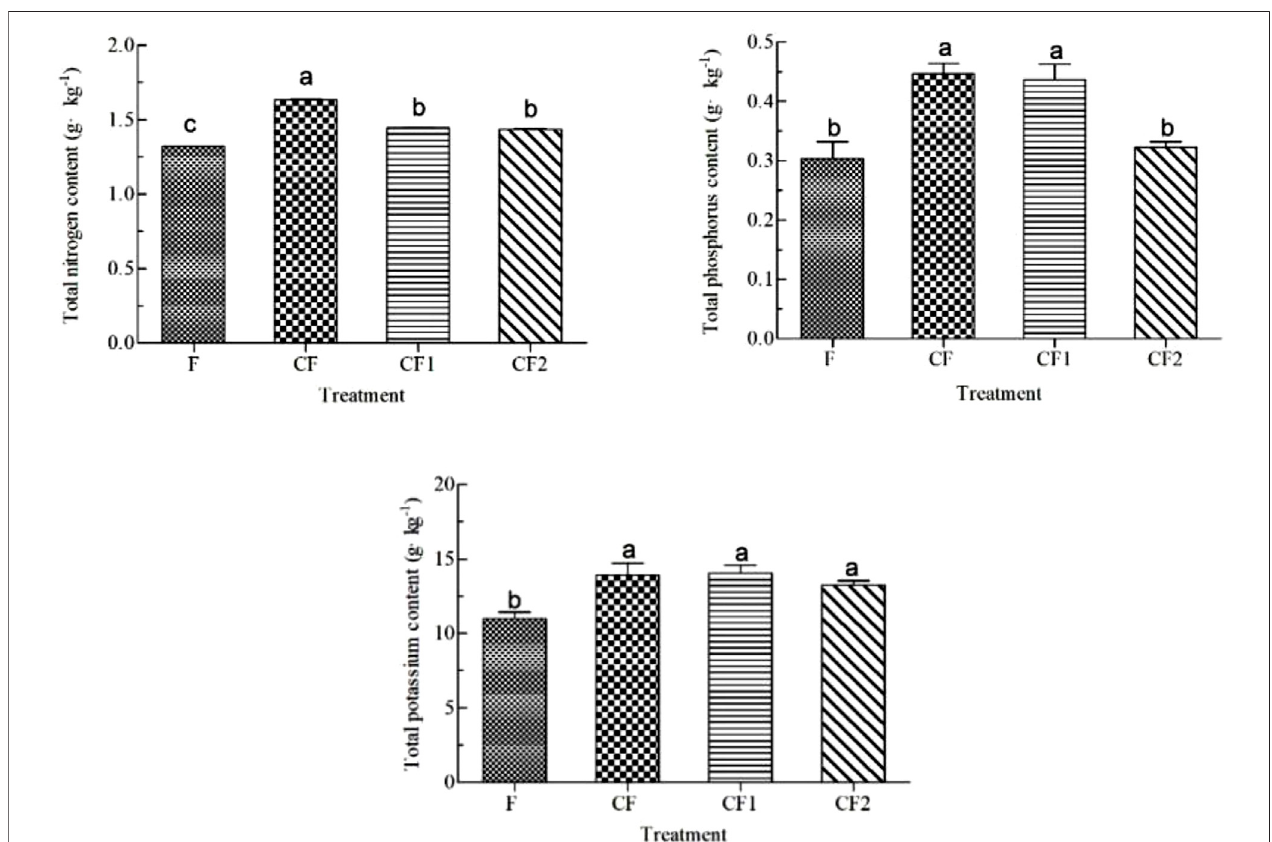
FIGURE 7 | Effect of co-application of biochar and chemical fertilizer on soil total nutrient in the paddy soil.